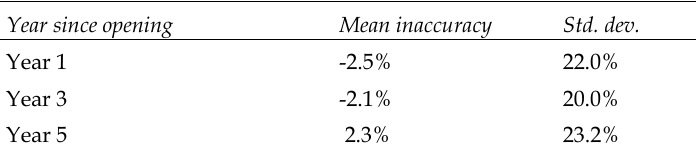
Table 3. Demand ramp-up.